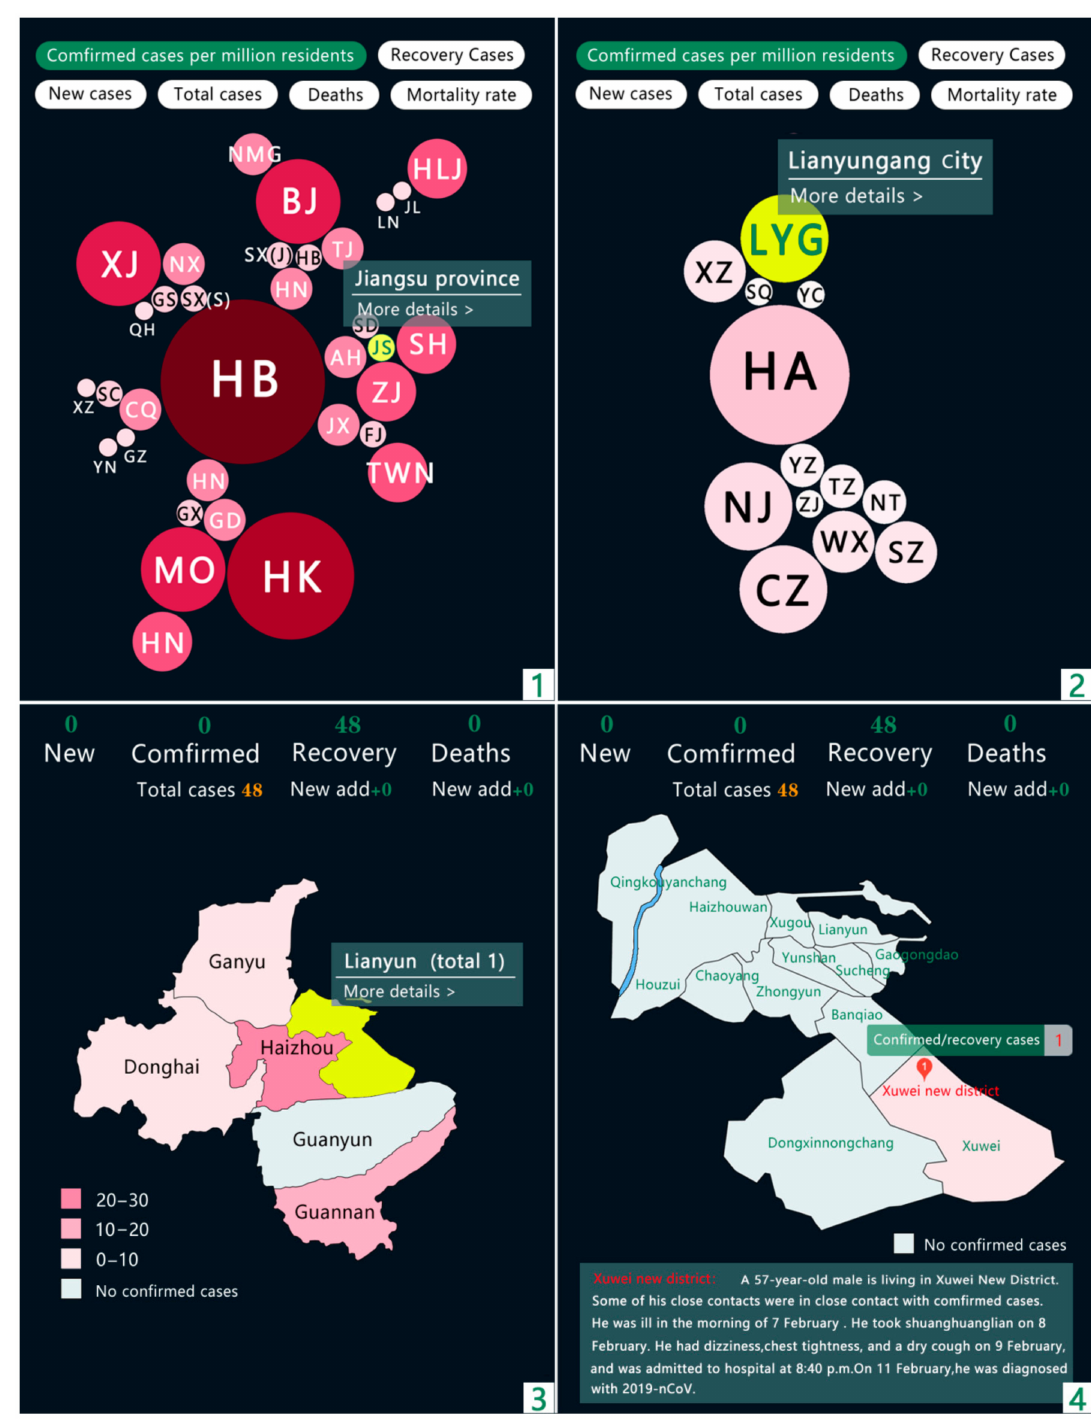
Figure 7. Content architecture of the pandemic situation’s visualization (as of 1 September